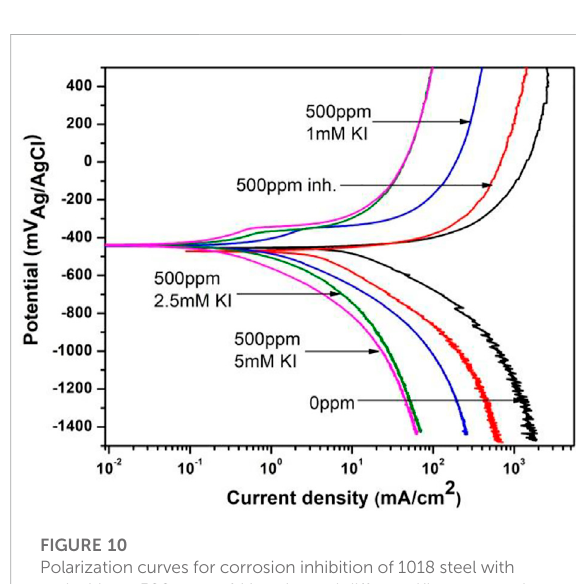
FIGURE 9 Polarization curves for corrosion inhibition of 1018 steel with and without 500 ppm of M. sativa and different KI concentrations at 40 ° C.